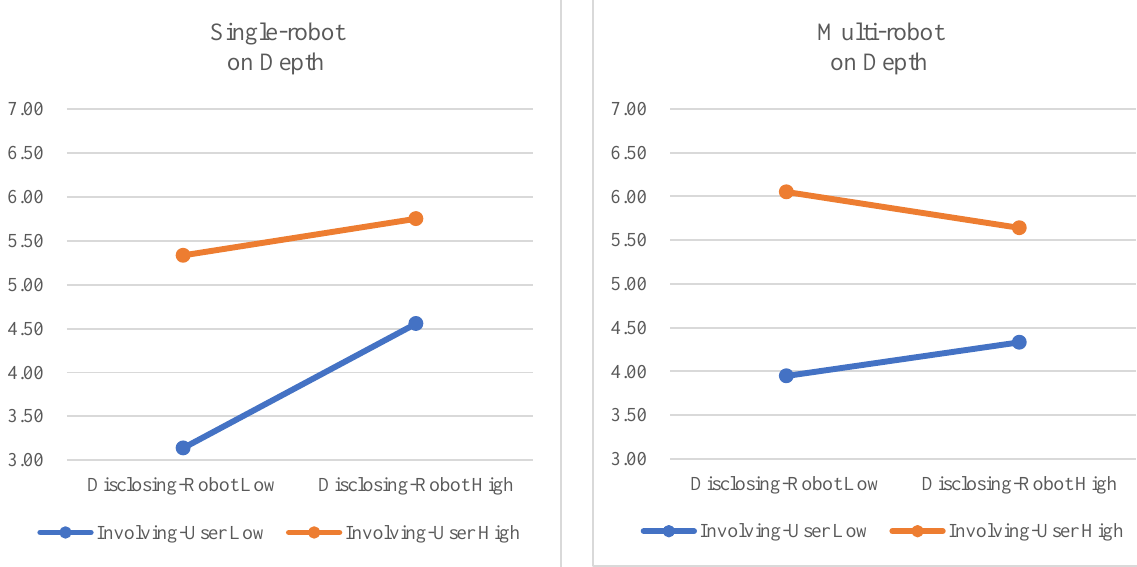
Figure 8. Moderation effects of multi-robot on depth.